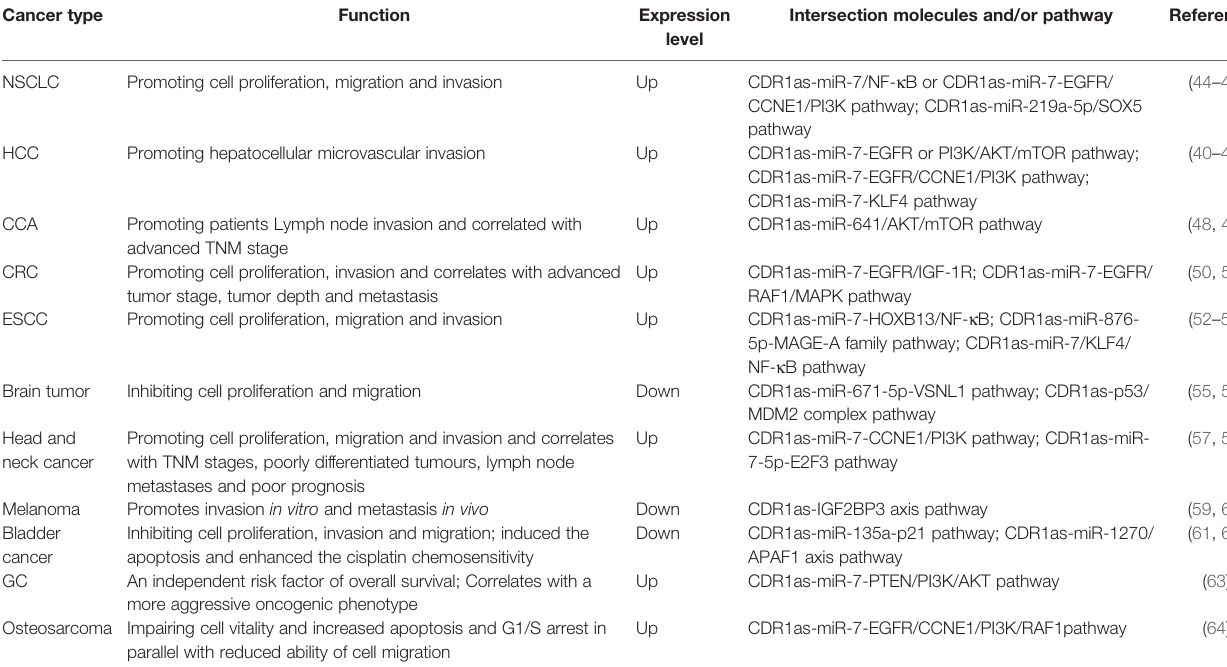
TABLE 1 | Summary of the role of CDR1as in cancers so far.